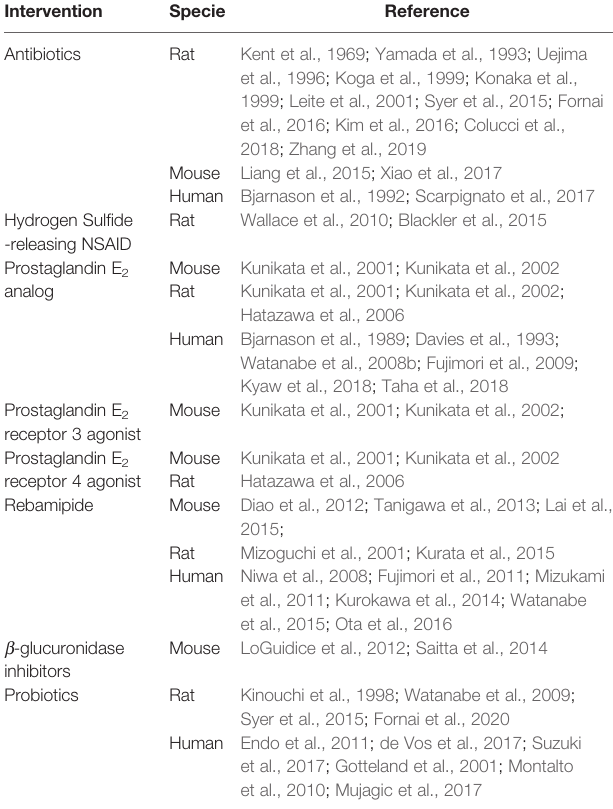
TABLE 1 | Potential therapeutic interventions to reduce NSAID-induced